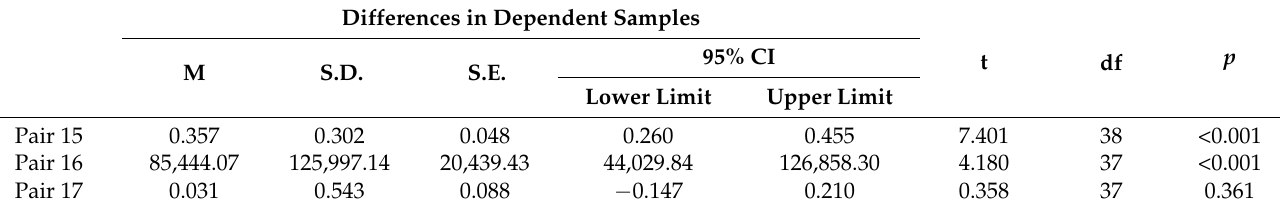
Figure 5. Independent sample mean values in the area of care services in healthcare. Table 11. Test for dependent samples. The mean values of the examined variables in the area of healthcare organization in 2019–2020 allow for the observation that all these variables declined during the pandemic